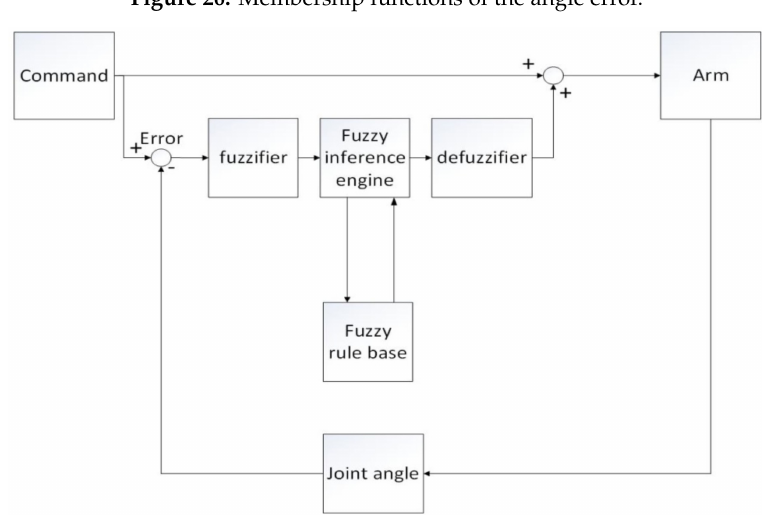
Figure 26. Membership functions of the angle error.